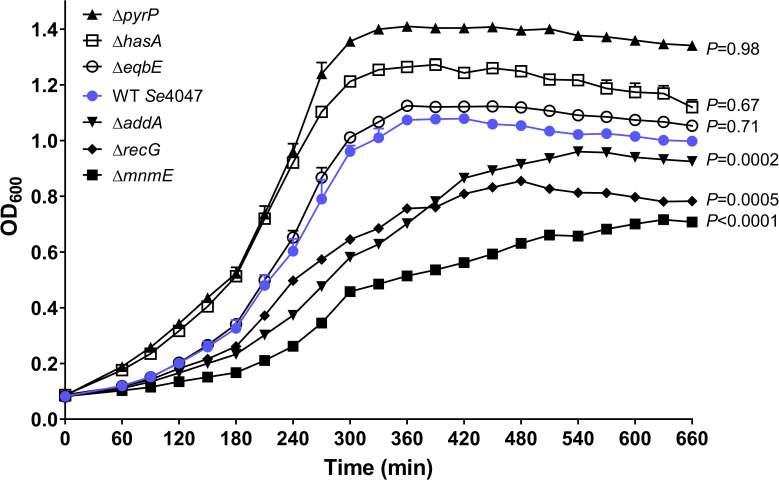
Growth curves of the parental
S. equi
 subsp.
equi
 strain Se4047 and ΔpyrP, ΔhasA, ΔeqbE, ΔaddA, ΔrecG and ΔmnmE deletion mutation strains grown in THB at 37 °C in a humidified atmosphere in the presence of 5 % CO2. Error bars indicate the se. The significance of changes in doubling time using a two-sided Student’s t-test are indicated.